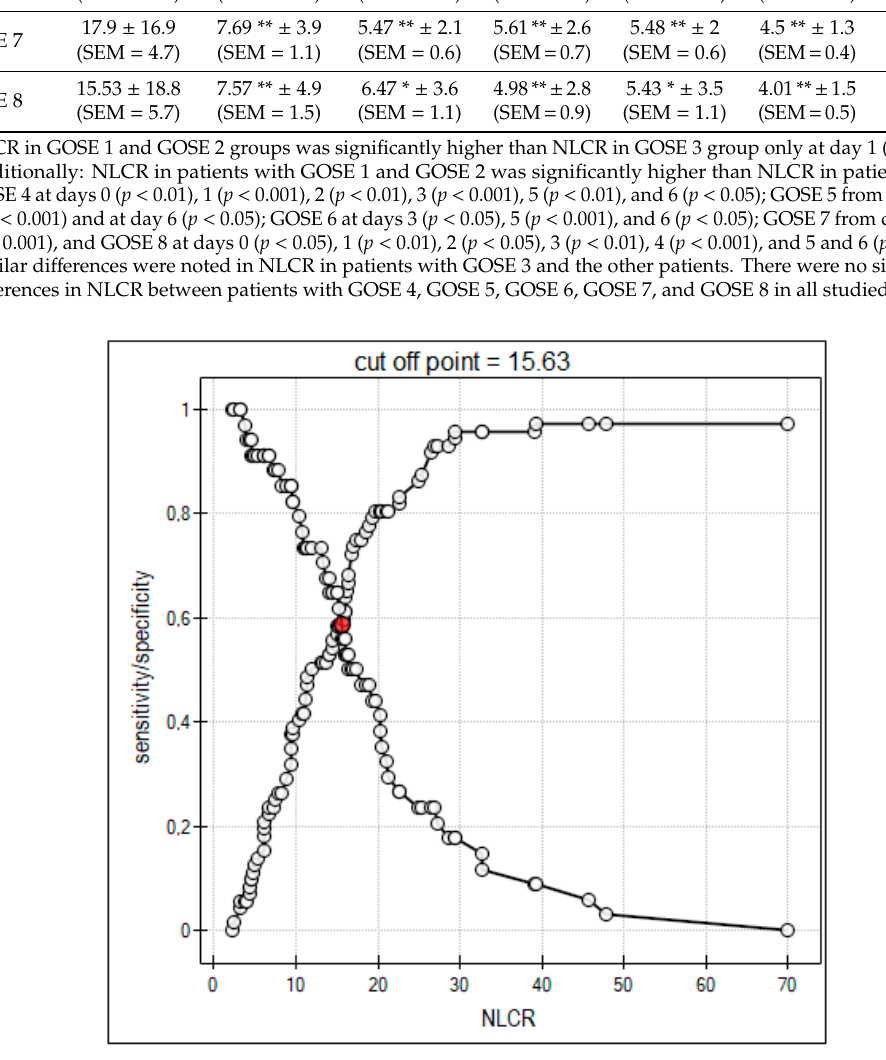
Figure 3. The ROC (receiver operator characteristic) curve for the neutrophil-to-lymphocyte count ratio (NLCR) in accordance with the mortality risk. An increase in NLCR with a cut-off point of 15.63 increases risk of death.